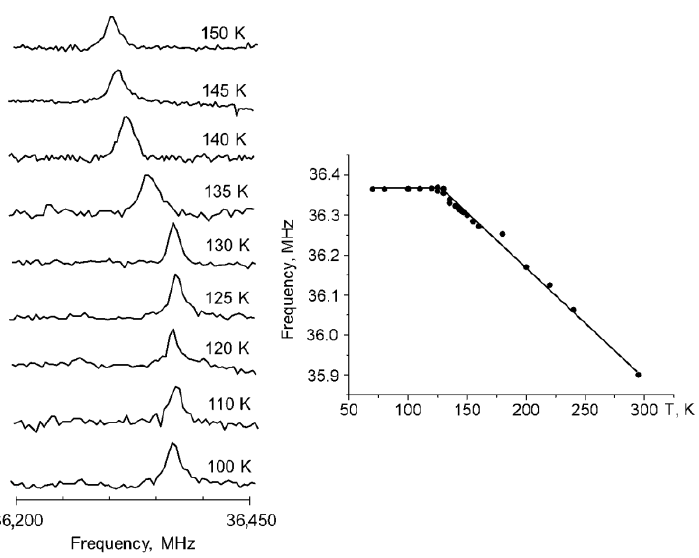
Figure 3. The 35 Cl NQR spectra ( left side ) and the temperature dependence of the 35 Cl NQR frequency ( right side ) of 5-chloro-3-nitro-2-hydroxyacetophenone.